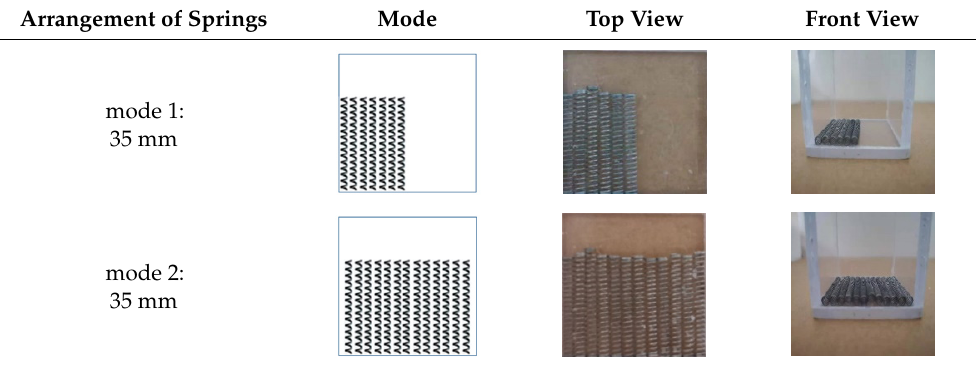
Table 2. Arrangement of springs and particles.